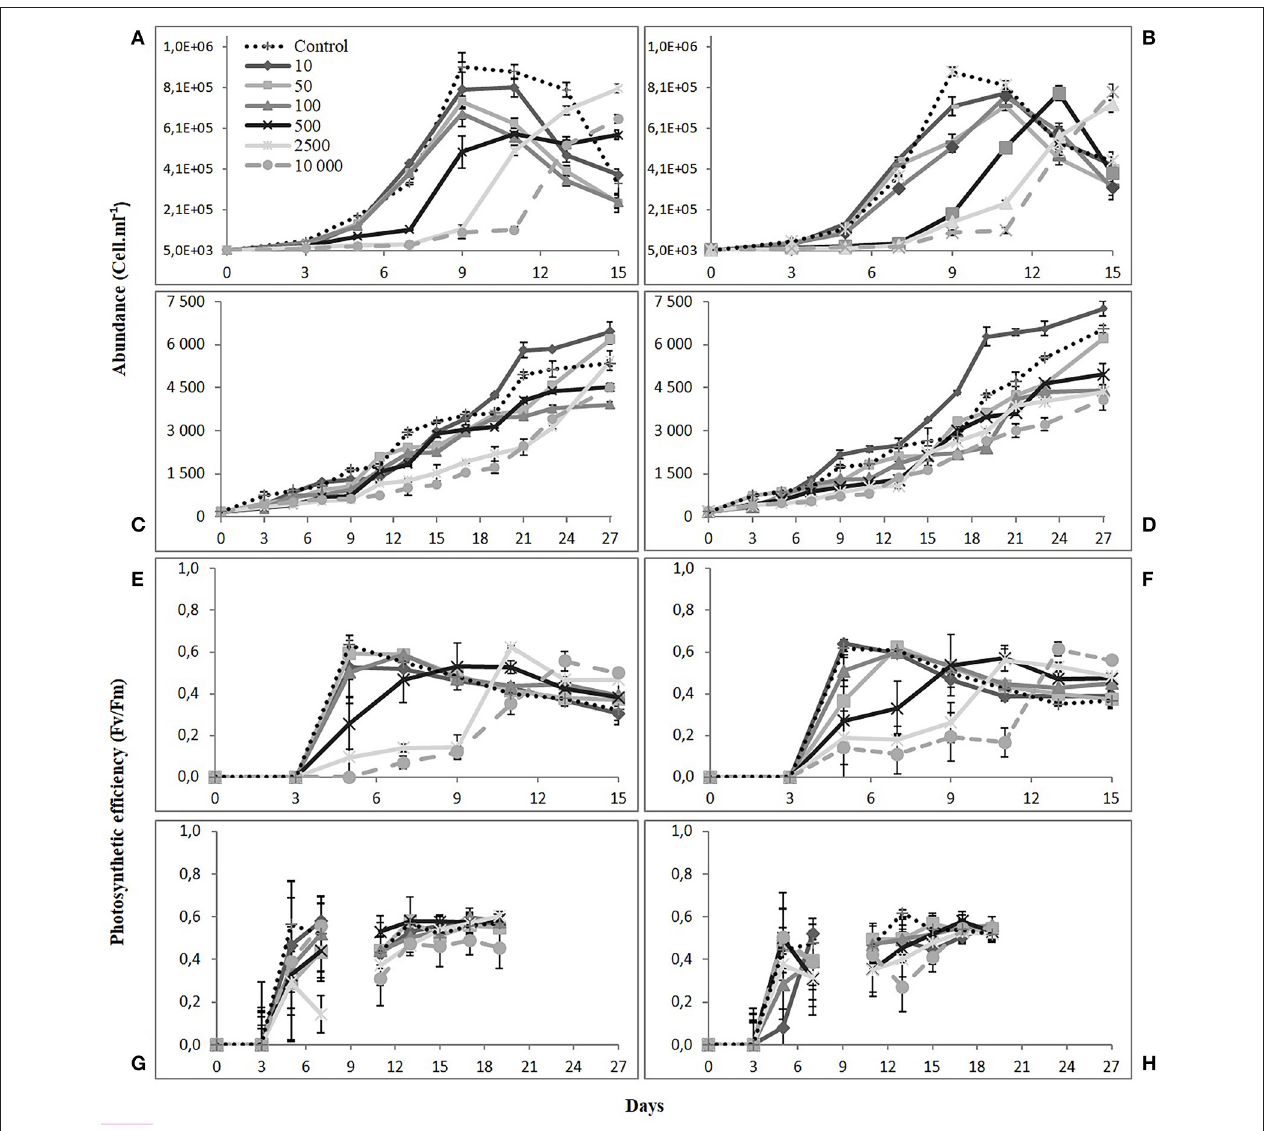
FIGURE 2 | Cell abundance (cell mL − 1 ) and photosynthetic efficiency (Fv/Fm) for Skeletonema costatum (A,B,E,F) and Alexandrium catenella . (C,D,G,H) over time. Left graphs (1nM Fe) and right graphs (10nM Fe). Error bars: standard deviation ( n =